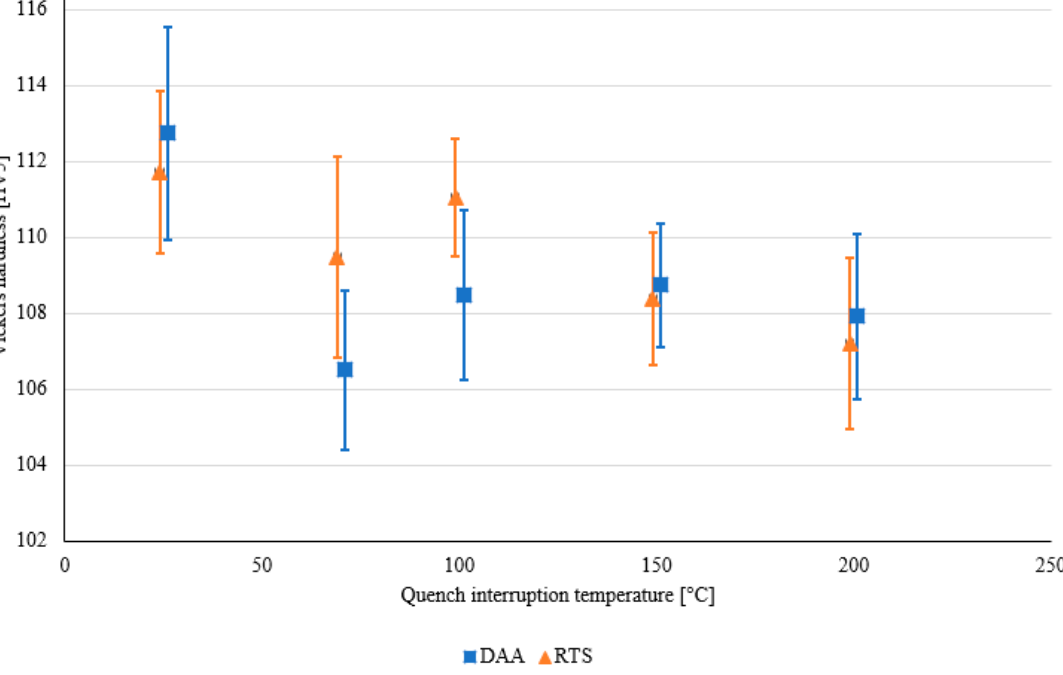
Figure 5. The average Vickers hardness for samples being quench interrupted and directly artificially aged (DAA) or stored at room temperature (RTS). The standard deviations are represented by error bars. Overall, the e ff ect of direct artificial aging does not seem to be significantly beneficial regarding these results. The samples being deformed and quenched to room temperature obtained higher hardness than the samples being quench